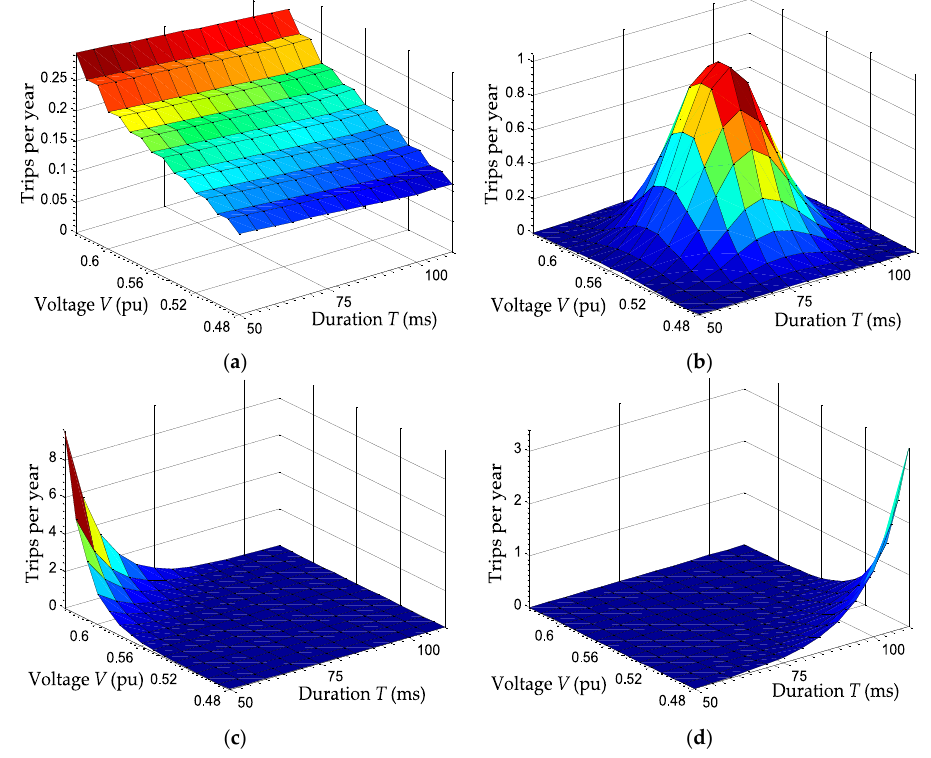
Figure 17. Number of expected trips per year of various voltage–tolerance characteristics for PC: ( a ) uniform; ( b ) normal; ( c ) exponential; and ( d ) reverse exponential.